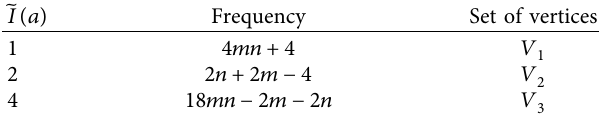
based on the degree of vertex. 2